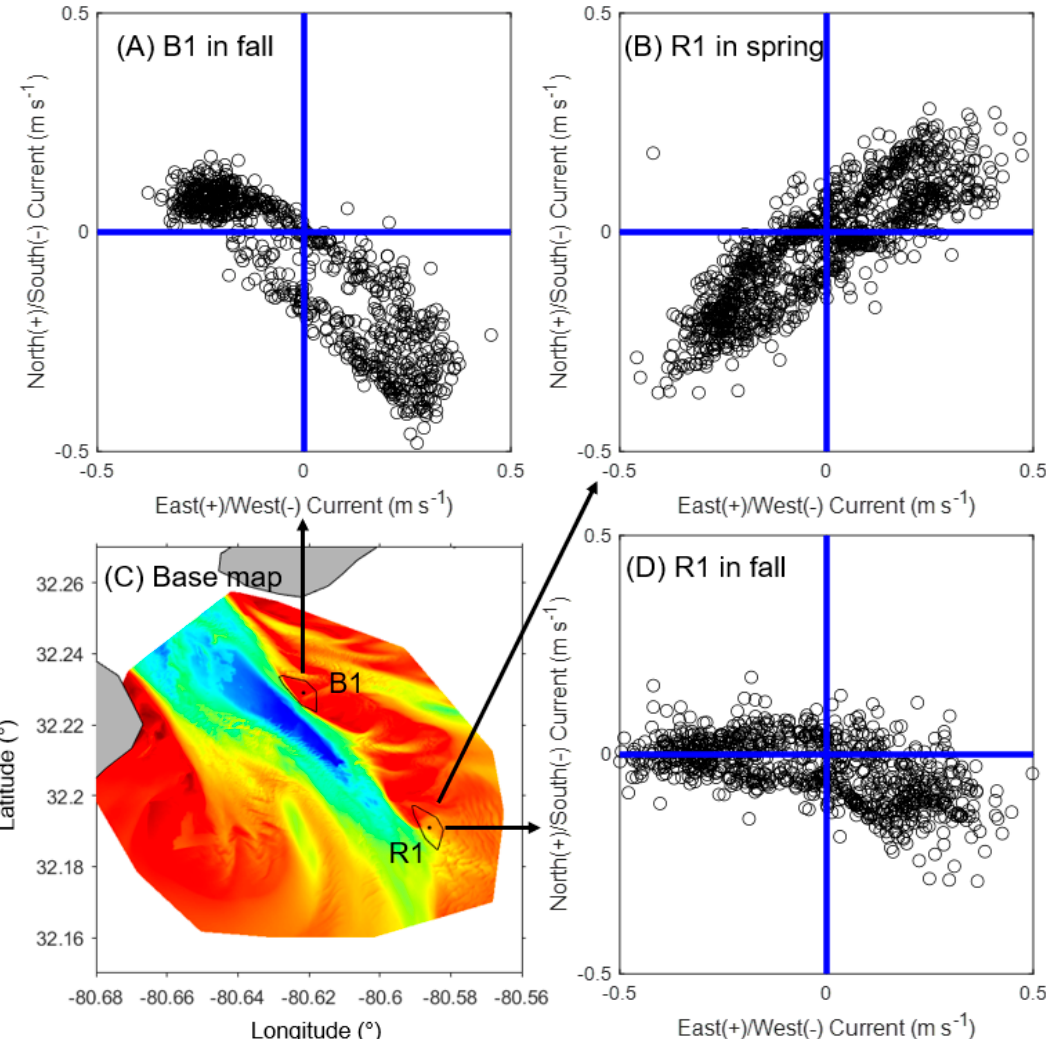
Figure 7. Scatter plots of east( + ) / west( − ) and north( + ) / south( − ) currents in m s − 1 from ( A ) ADV data collected at B1 in fall 2012 and PCADP data at 0.7 m above bed collected at R1 in spring ( B ) and fall ( D ) of 2012. ( C ) the base map for the study area.